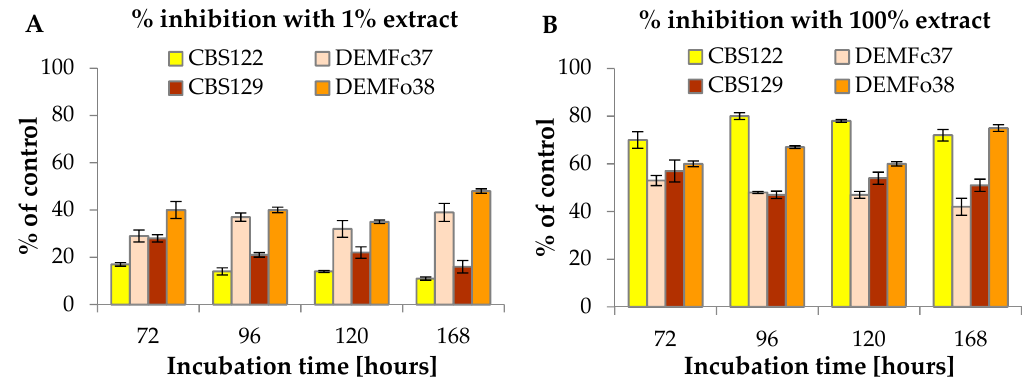
Figure 2. The percentage inhibition of mycelial growth of Fusarium culmorum (CBS122, Fc37) and Fusarium oxysporum (CBS129, Fo38) strains on PDA medium with addition of ( A ) 1% and ( B ) 100% F. vesiculosus extract, after 72 h, 96 h, 120 h and 168 h of incubation in a comparison with the control. Molecules 2019 , 24 , x FOR PEER REVIEW